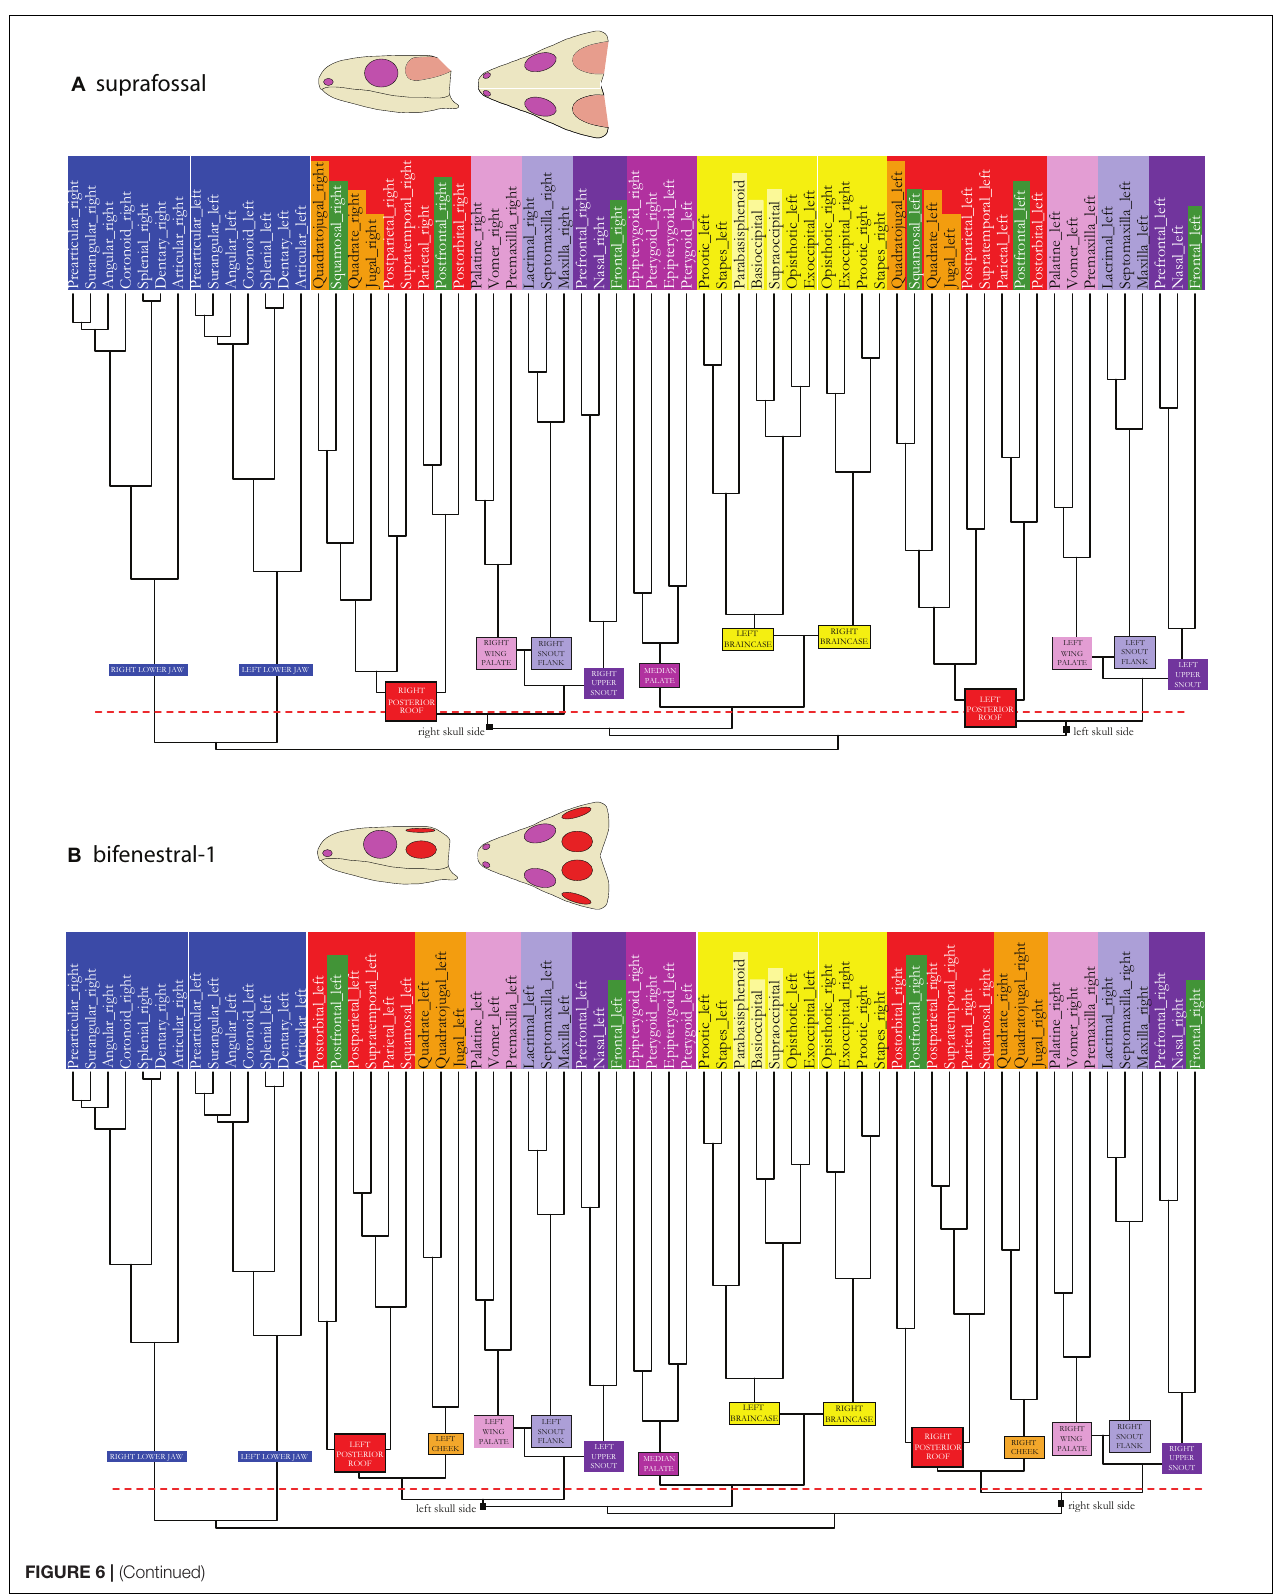
right skull side